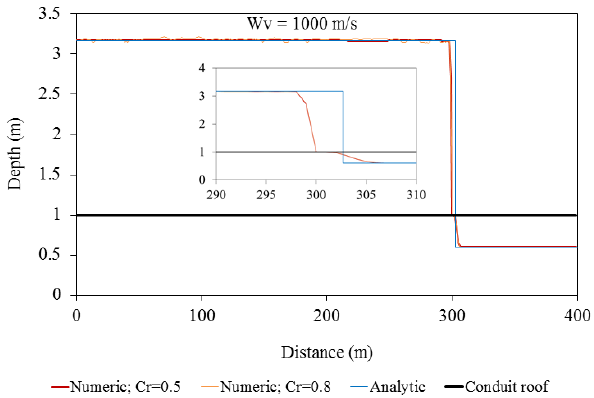
Figure 4. The numerical results at 10 s after the water level rises in a test reservoir with an acoustic speed of 1000 m/s (proposed HLL solver).